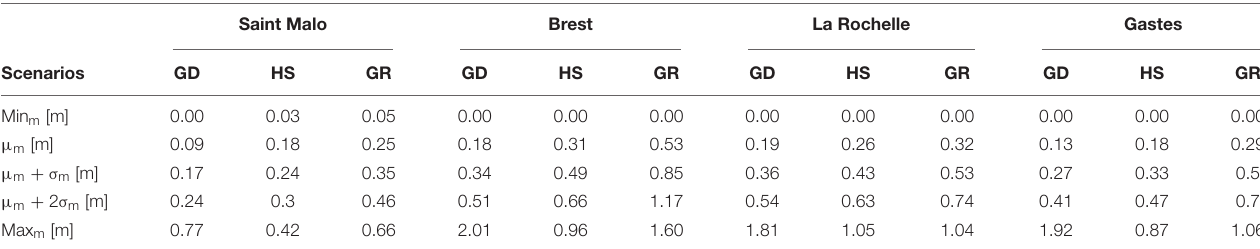
TABLE 8 | Maximum tsunami height distributions associated with the global database (GD), HorseShoe (HS), and Gorringe (GR) scenarios; µ m , σ m and Max m correspond to the mean, standard-deviation and maximum meta-modeled values. Saint Malo Brest La Rochelle